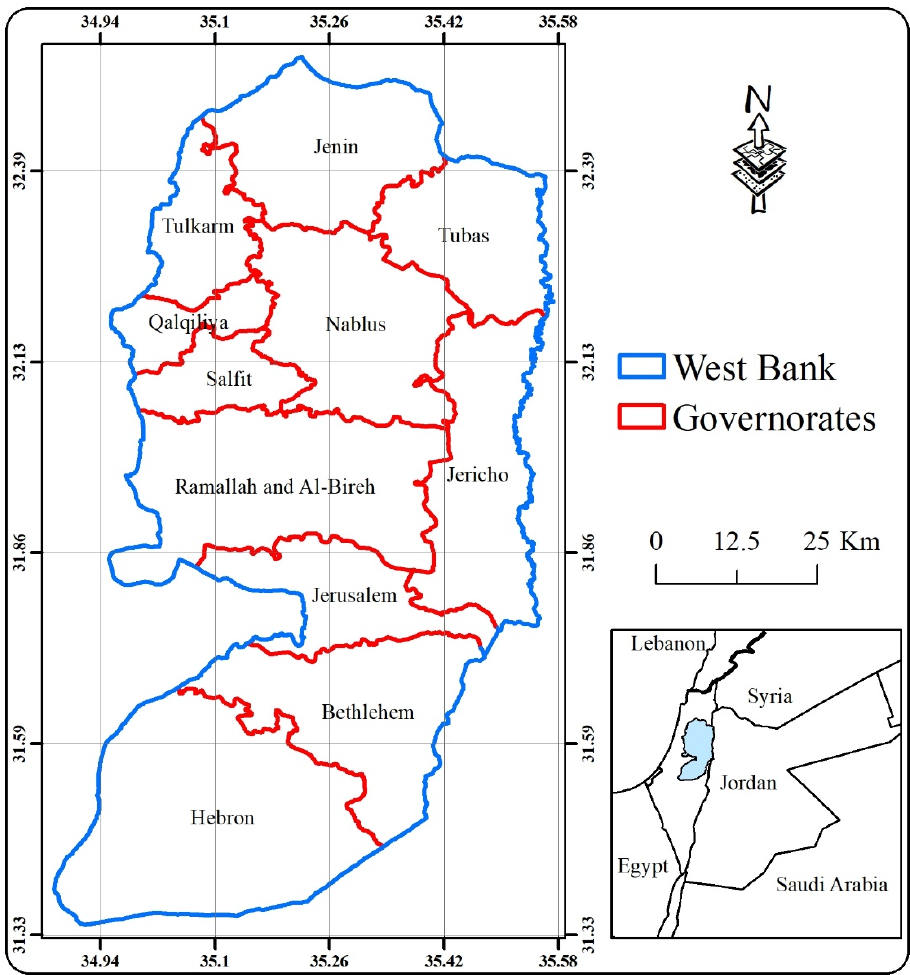
Figure 1. Administrative governates of the West Bank, Palestine. Geographically, the WB is largely made up of hills (700 and 900 m above sea level) that run north-south and then fall to the Jordan Valley and the Dead Sea on the east side. In general, the predominant climate is the Mediterranean, with rainy winters and hot, dry summers; the eastern and southern parts are much drier [16]. Surface water is mainly in the Jordan River and ephemeral wadis. However, since 1967, Palestinians do not have the right to access the river; therefore, they mainly rely on groundwater, the discharge from the different springs, and water purchased for domestic and agricultural use. the yearly rainfall (about 80%) falls during the winter [16] with an average runoff curve number of about 50 [17], which indicates the potential for implementing RWH.